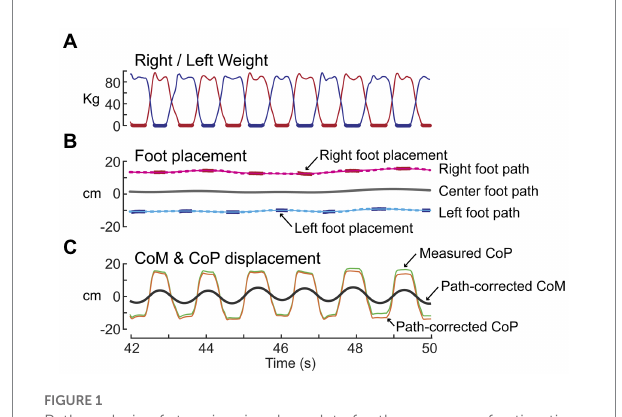
FIGURE 1 Path analysis of stepping-in-place data for the purpose of estimating the trajectory of the midpoint between the right and left foot locations over time. (A) Shows time courses of weight changes measured by the right (red) and left (blue) force plates. Thick lines indicate single-leg stance segments of gait. (B) Shows the processing of right and left foot placement data (red and blue bars) to calculate the right and left foot paths (thin solid lines) and then averaging of these paths to calculate the center foot path (thick black line). (C) The center foot path was used to derive path-corrected